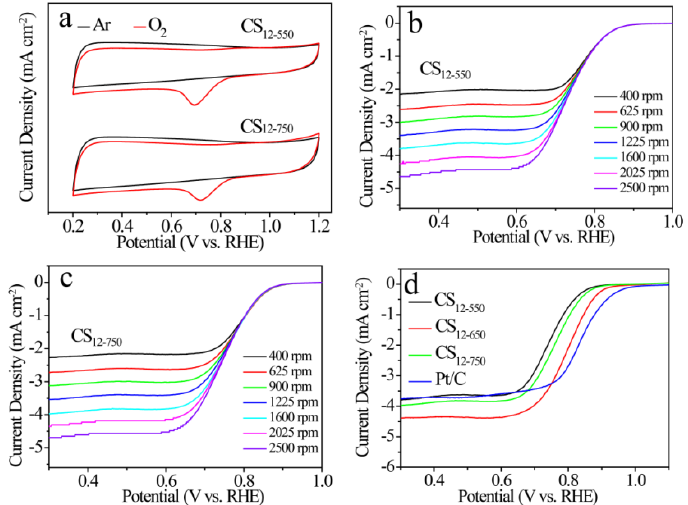
Figure 6. CV curves of CS 12-550 and CS 12-750 in Ar- or O 2 -saturated 0.1 M KOH aqueous solution with a scan rate of 50 mV/s ( a ). LSV curves of CS 12-550 ( b ) and CS 12-750 ( c ) and ( d ) LSV curves of CS 12-550 , CS 12-650 and CS 12-750 and the commercial 20 wt% Pt/C in O 2 -saturated 0.1 M KOH aqueous solution at a rotation rate of 1600 rpm and a scan rate of 10 mV/s.